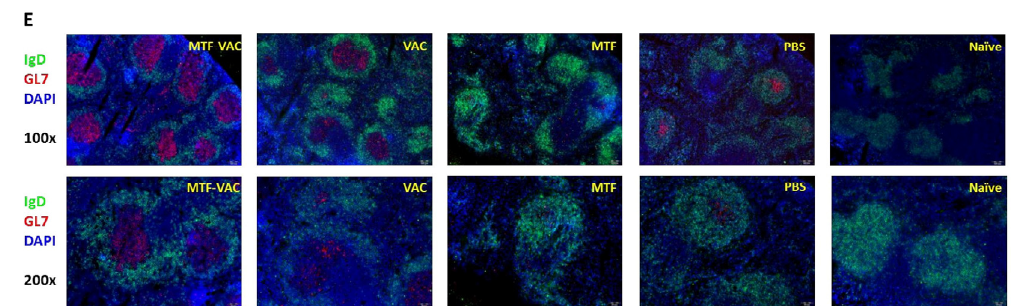
Figure 4. The e ff ect of MTF-VAC and VAC on mice spleens before and after influenza virus challenge. Groups of mice were immunized 7 days before a lethal virus challenge with MTF-VAC, Vac, MTF, or PBS. At day 0, 10LD 50 of the 415742Md virus was inoculated through the intranasal route. Spleen samples were collected on day 0 and 2 dpi. Flow cytometry was applied for assessing frequencies of T FH cells with staining of Zombie Violet live / dead dye, anti-mouse CD3 ε , anti-mouse CD4, anti-mouse PD-1, and anti-mouse CXCR5 antibodies. Frozen sections were prepared from 2 dpi spleen samples and stained with anti-mouse IgD and anti-mouse GL7 antibodies. The stained tissue slides were examined under the fluorescent microscope Olympus BX53. B cell follicles expressing IgD + GL7 − or IgD + GL7 + were counted with randomly renamed photos to avoid bias. ( A ) Schedule of influenza vaccine, virus challenge, and spleen sample collection. ( B ) Gating strategy and representative flow cytometry profiles of splenic T FH cells obtained from mice. ( C ) T FH cell frequencies in mice spleens assessed by flow cytometry. ( D ) Percentage of GL7 + B cell follicles (GC) among all B cell follicles (IgD + ) in spleen. ( E ) Representative immunofluorescence staining of mouse spleen. MTF-VAC, miltefosine (0.2 mg) + vaccine group; Vac, vaccine only group; MTF, miltefosine (0.2 mg) only group; PBS, PBS only group. Data collected from 8 mice per group (3 independent experiments) for ( B , C ). Data were collected from 3 mice per group (1 independent experiment) for ( D , E ). * for p < 0.05; ** for p < 0.01; *** for p < 0.001, **** for p < 0.0001; calculated by two-way ANOVA followed by a Tukey’s multiple comparison test. Error bars represent standard error of the mean (SEM).